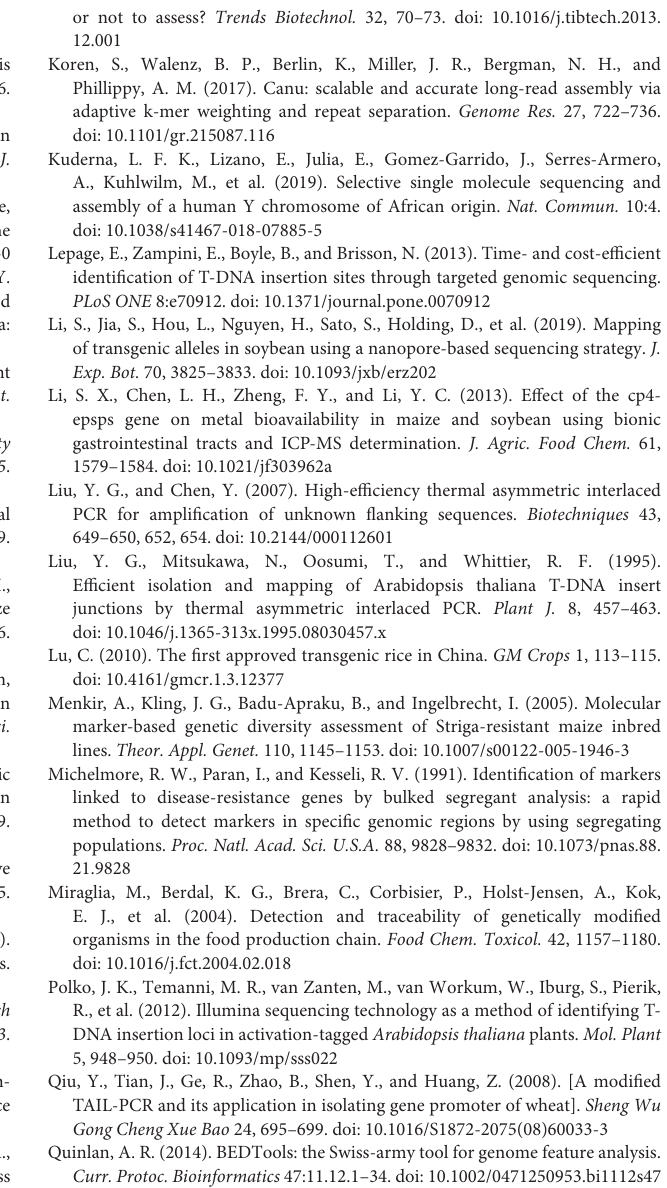
Supplementary Figure 1 | Identifying the transgenic and non-transgenic individuals from the F 2 population via polymerase chain reaction (PCR). Supplementary Data 1 | The sequences of 10 reads from the nanopore sequencing, with one end mapped onto the vector and the other end to the maize